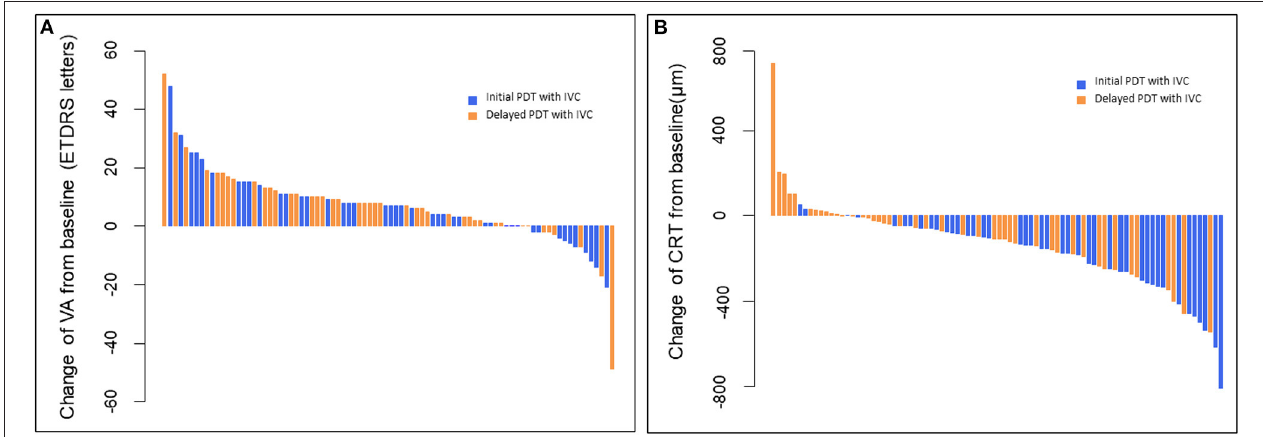
FIGURE 3 | (A) Waterfall plots of BCVA changes from baseline to month 12 for individual patients. These plots showed that all the BCVA scores improved except 10 patients in initial PDT with IVC and 6 patients in delayed PDT with IVC. (B) Waterfall plots of CRT changes from baseline to month 12 for individual patients. These plots showed that all the CRT thicknesses decreased from baseline except two patients in initial PDT with IVC and 11 patients in delayed PDT with IVC. BCVA, best-corrected visual acuity; CRT, central retinal thickness; PDT, photodynamic therapy; IVC, intravitreal injection of conbercept.